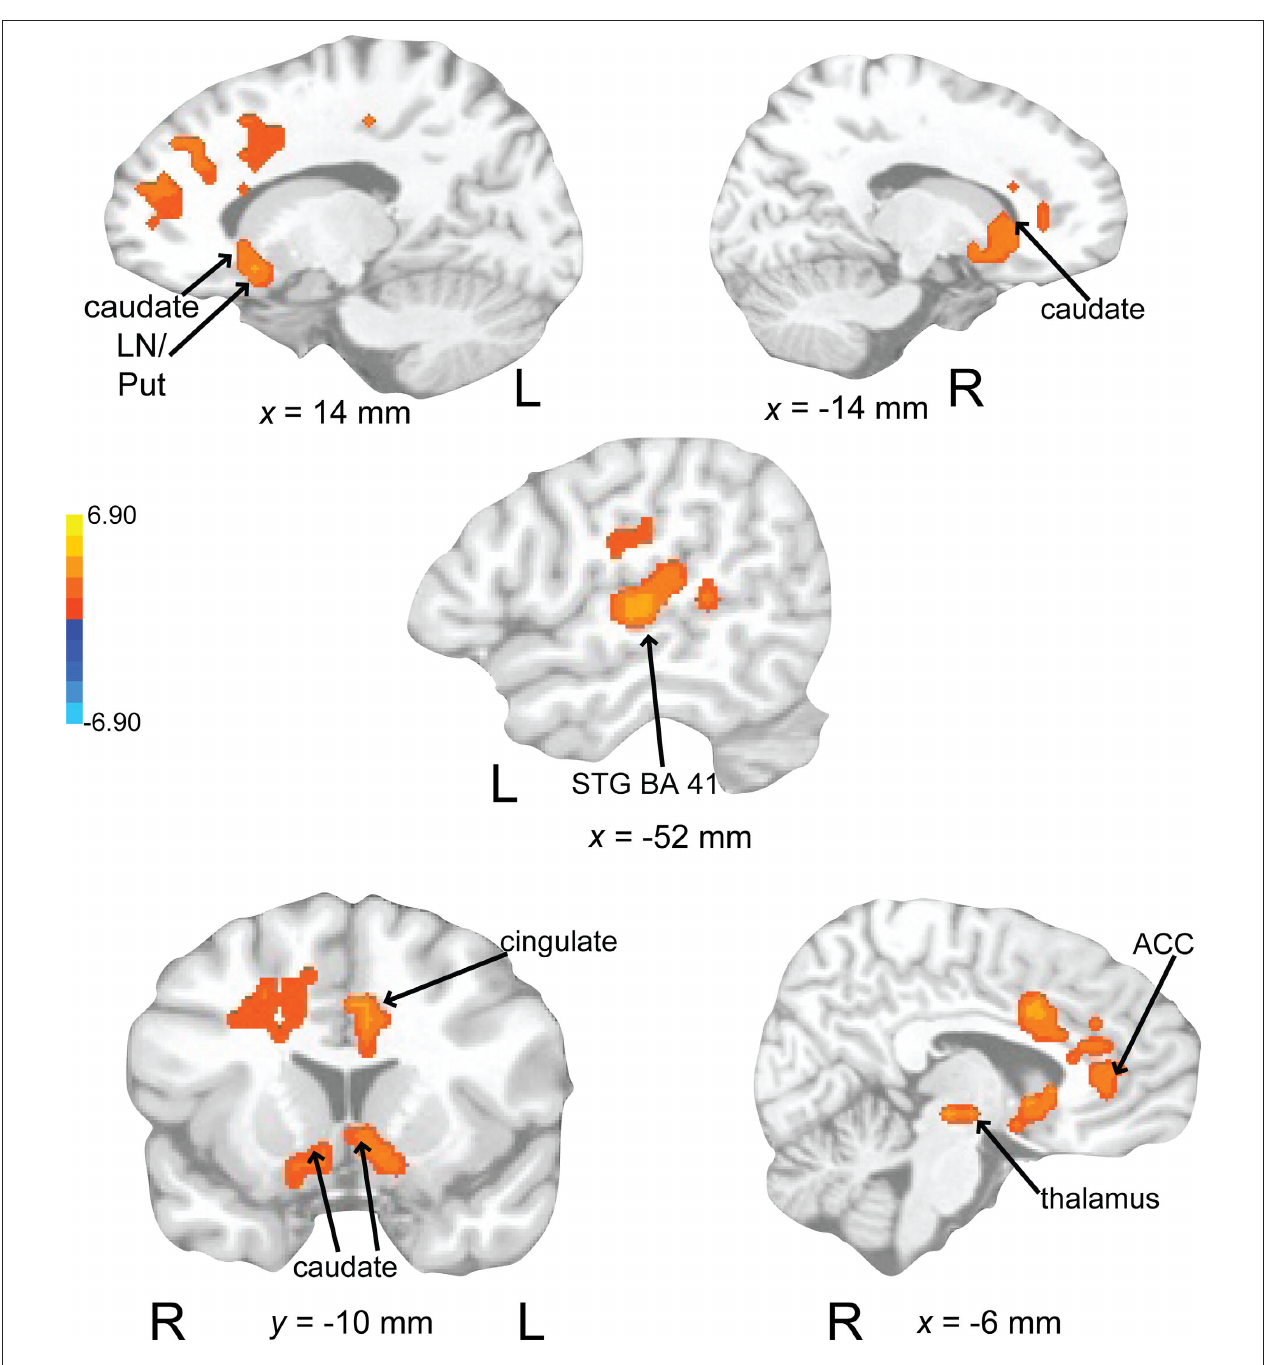
FIguRe 10 | Brain regions where BOLD signal was greater during the auditory attend 2 compared to auditory attend 1 condition ( p < 0.002 corrected). Red to yellow colored voxels represent brain areas where auditory attend 2 > auditory attend 1 . The coronal slice is shown with the left (L) on the left side of the figure. The colorbar reflects t -values. STG, superior temporal gyrus; LN, lentiform nucleus; Put, putamen; ACC, anterior cingulate